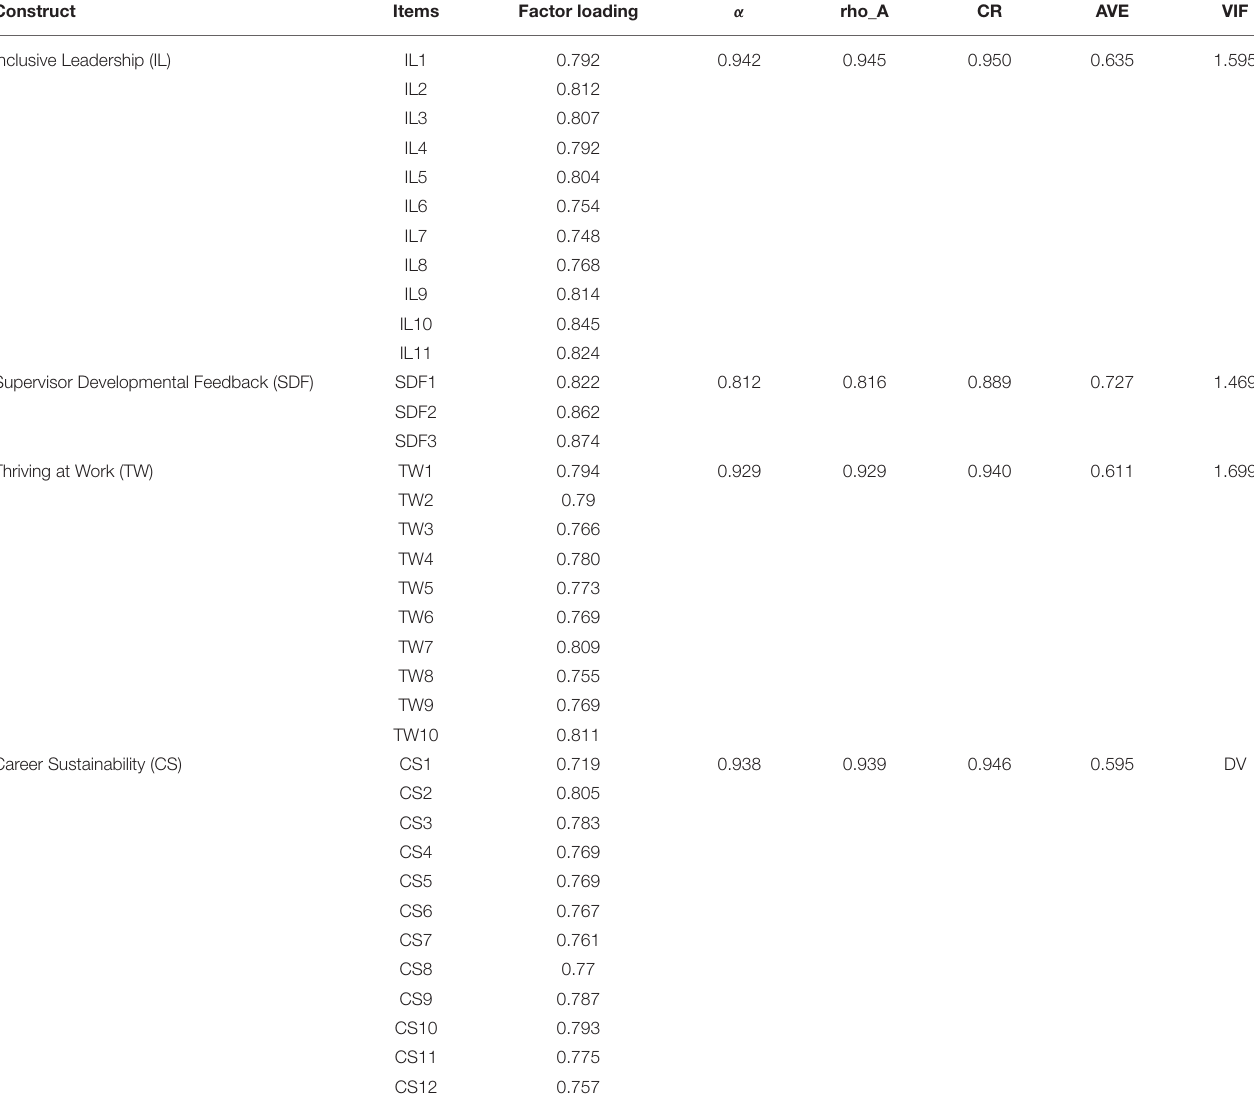
TABLE 4 | Confirmatory factor analysis results for the measured variables. Construct